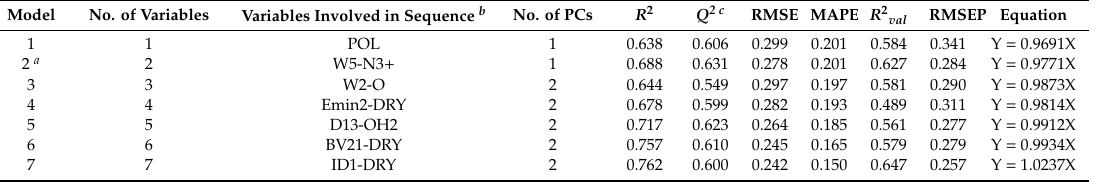
a Optimal PLS model with 2 descriptors; b POL: average molecular polarizability; W5-N3 + : hydrophilic regions generated by the sp3 NH3 probe at energy level of − 3.0 kcal / mol (More details please refer to Table S1); c leave-one-out cross-validation.